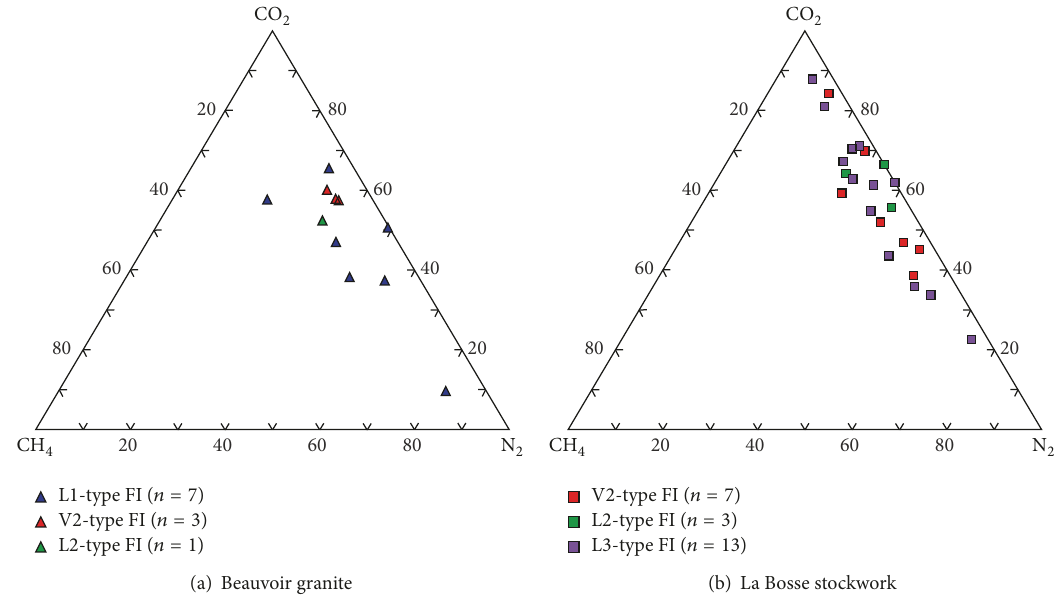
Figure 7: Ternary diagrams CO 2 -CH 4 -N 2 showing the gas compositions of fluid inclusions from the Beauvoir granite (a) and the La Bosse stockwork (b) determined by Raman spectrometry. Representative Raman data of the different fluid inclusions analysed are given in Table 1.